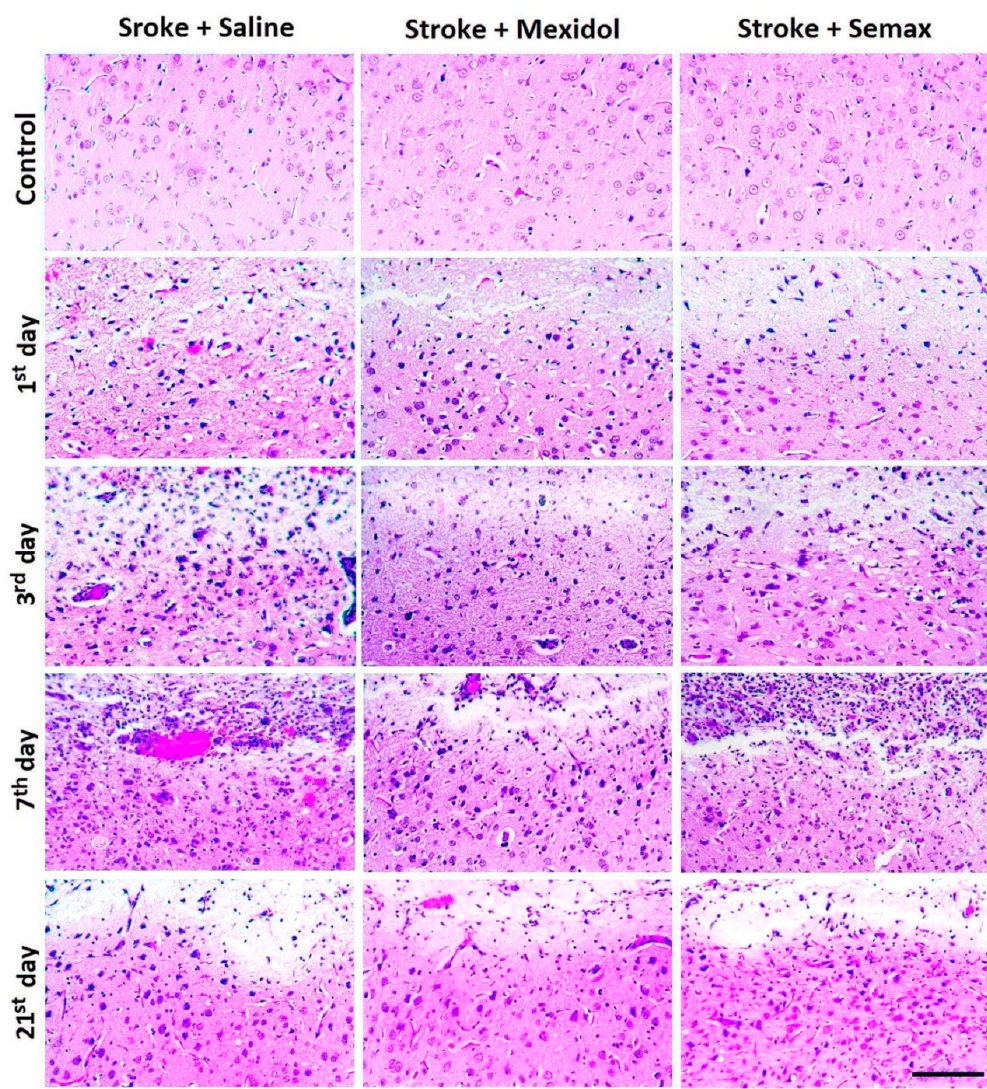
Figure 4. Representative microphotographs of pathomorphological alterations in the penumbral area within 21 post-ischemic days and a 7-day course of Mexidol and Semax treatments. Frontal section through the infarction and penumbra. A fragment of the infarction (pale-stained area) is shown at the top of the photomicrographs. The slices were stained with H&E. Scale bar: 100 μ m.